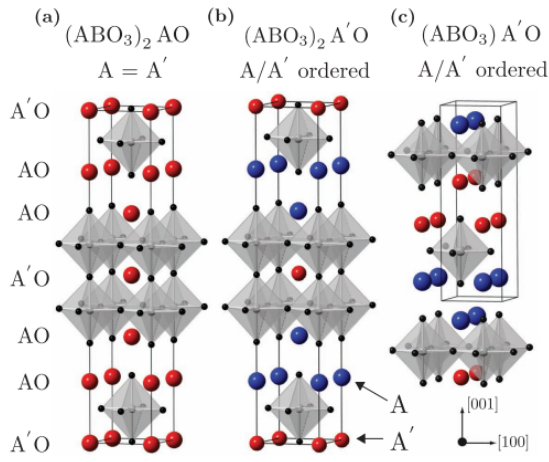
Fig. 7 (a) The (cid:1866) = 2 Ruddlesden–Popper structure (without octahedral rotations) with a single A -cation. (b) A/A′ ordered n = 2 phase. (c) A/A′ ordered (cid:1866) = 1 phase. Reproduced with permission from Ref. [145], © WILEY - VCH Verlag GmbH & Co. KGaA, Weinheim 2013. number of “ A ” cations per unit cell. However, symmetrical ordering of “ A ” cations in (ABO layered perovskite can induce ferroelectricity [145]. The relative magnetoelectric properties corresponding to HIF is also explored in ABO However, till date it is not explored yet in A layered perovskites